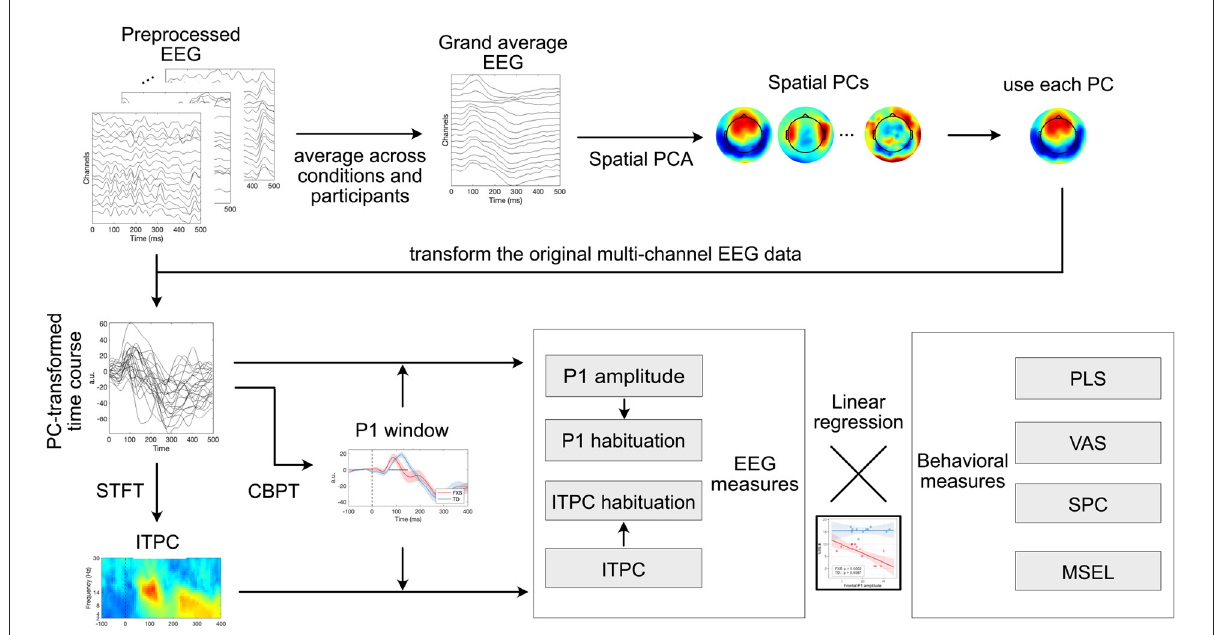
FIGURE2 A schematic diagram for all the analyses in this study. For intelligibility, only 16 out of 128 channels are displayed in “Preprocessed EEG” and “Grand averaged EEG”. Each line in “PC-transformed time course” represents the average ERP of an individual. Instantaneous phase was calculated from single trials and then averaged across trials for ITPC. PCA, principal component analysis; a.u., arbitrary unit; STFT, short-time Fourier transform; ITPC, inter-trial phase coherence; CBPT, cluster-based permutation test; PLS, Preschool Language Scales; VAS,